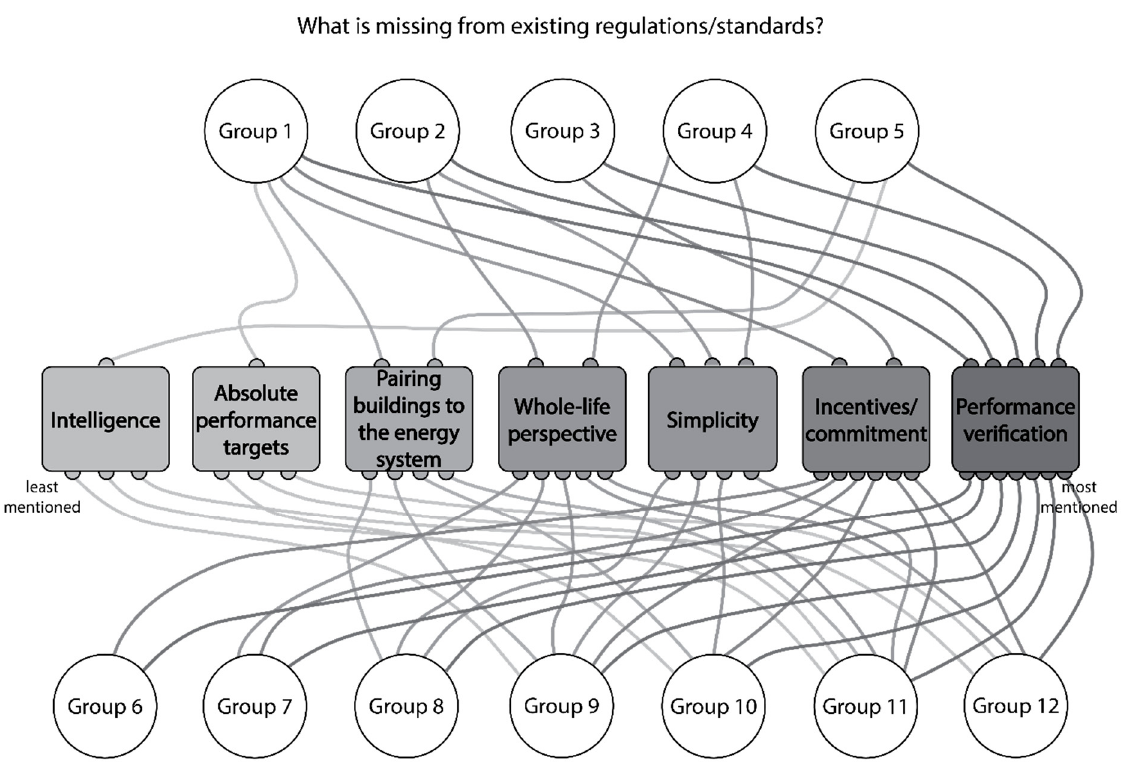
Figure 2. A stakeholder–issue interrelationship diagram demonstrating what is missing from exist ‐ ing regulations/standards according to different groups of